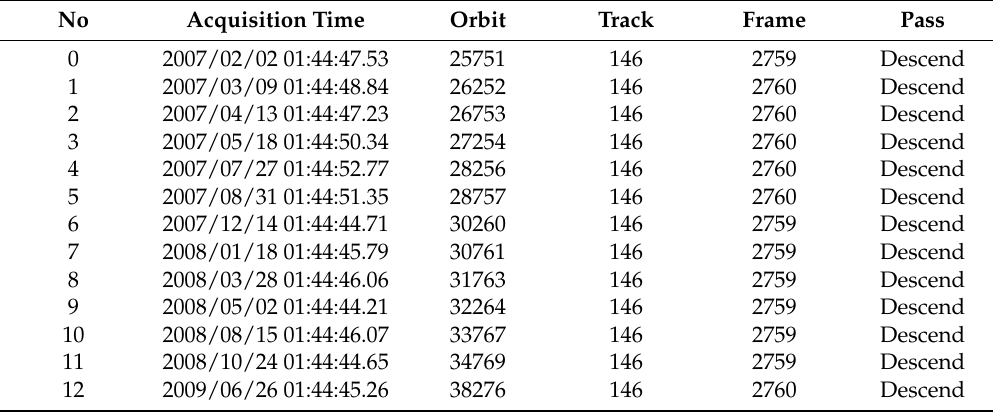
Table 2. ENVISAT ASAR images over Mt. Baekdu during the 2007–2010 period.